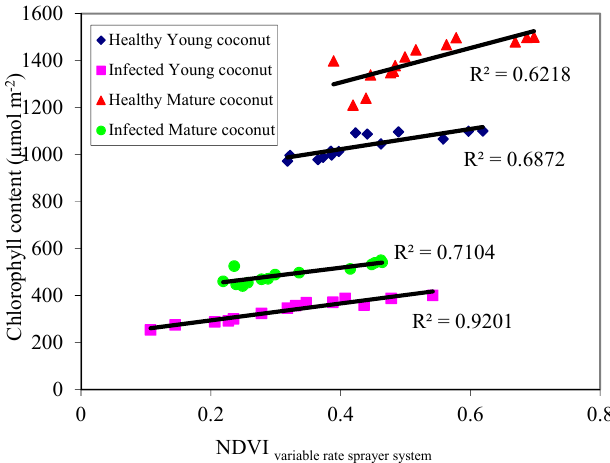
Figure 7. Estimation of leaf chlorophyll content using the normalized differential vegetation index (NDVI) and variable rate sprayer system for healthy and infected coconut trees.